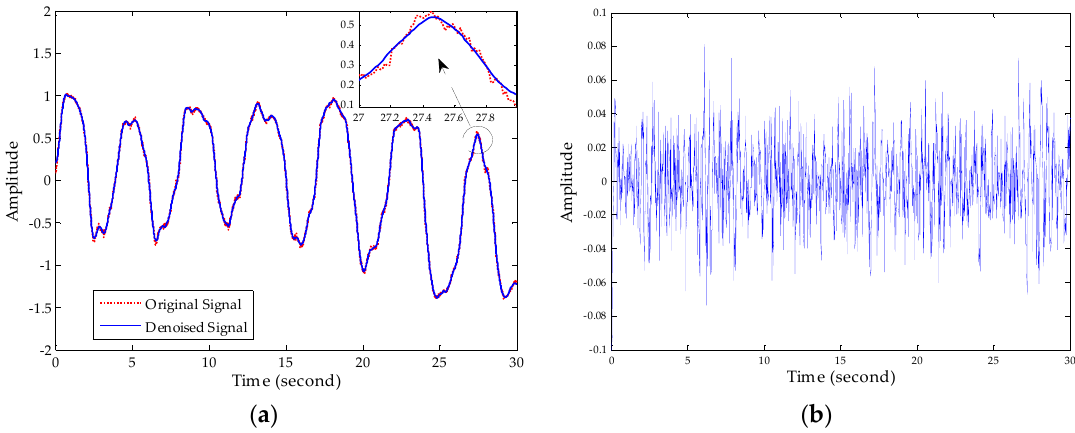
Figure 11. Performance of noise reduction. ( a ) Comparison of original vital sign signal with the denoised signal; ( b ) noise removed after denoising processing.